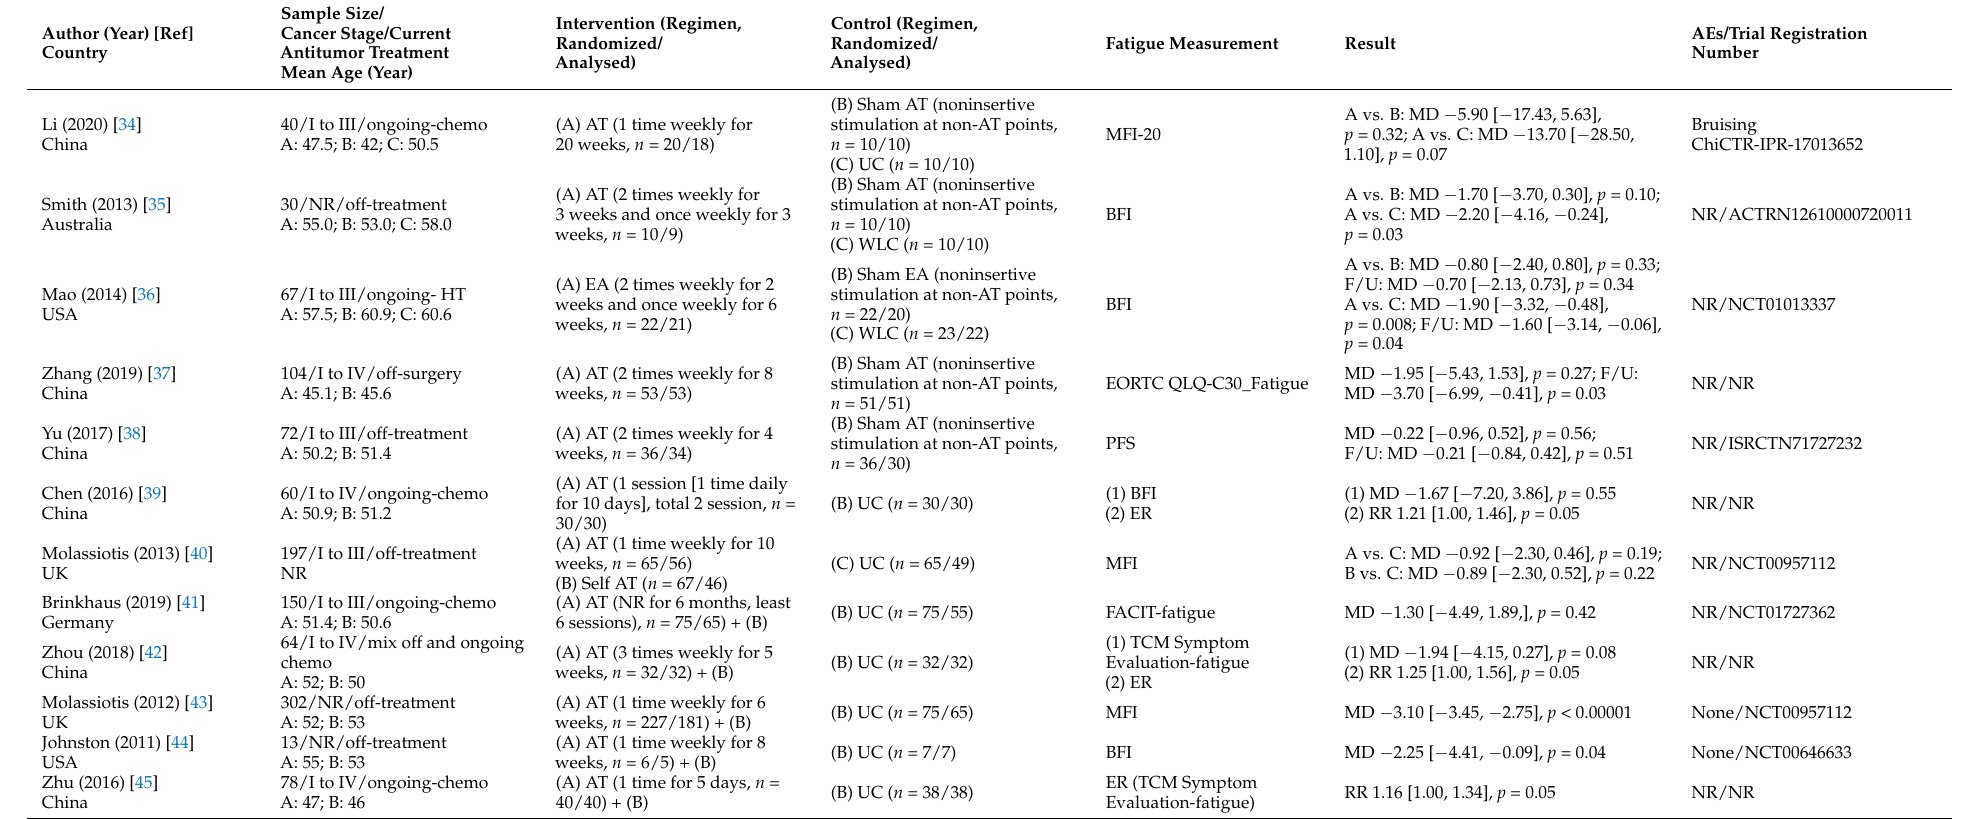
Table 1. Characteristics of the included RCTs with AT for cancer-related fatigue in breast cancer